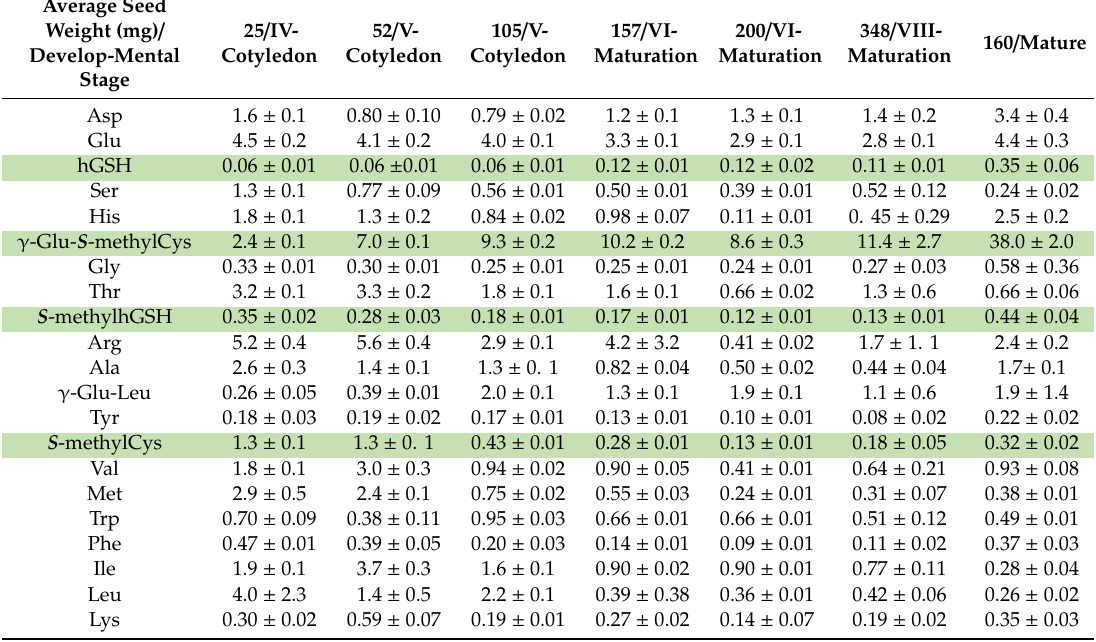
Table 1. Free amino acid profiles in developing seeds of BAT93. Metabolites related to S -methylcysteine are